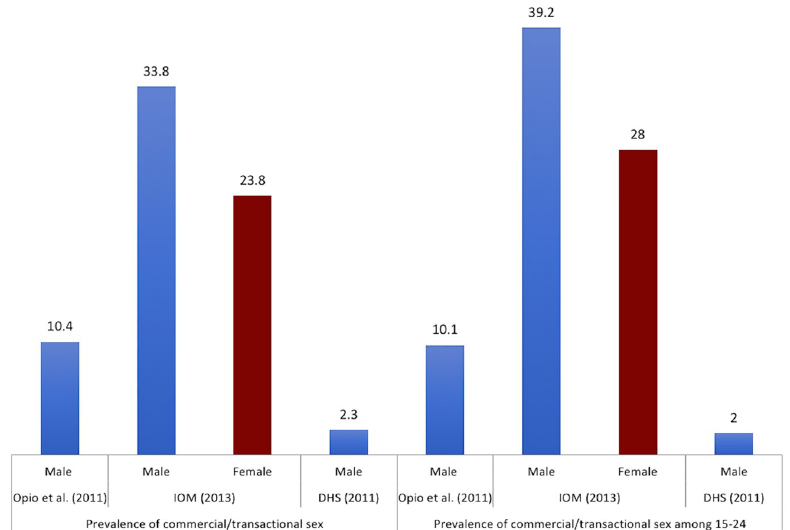
Fig 9. Commercial/Transactional sex in the past 12 months. IOM: International Organization for Migration. DHS: Demographic Health Survey. The numbers represent the prevalence reported as percentage (%).